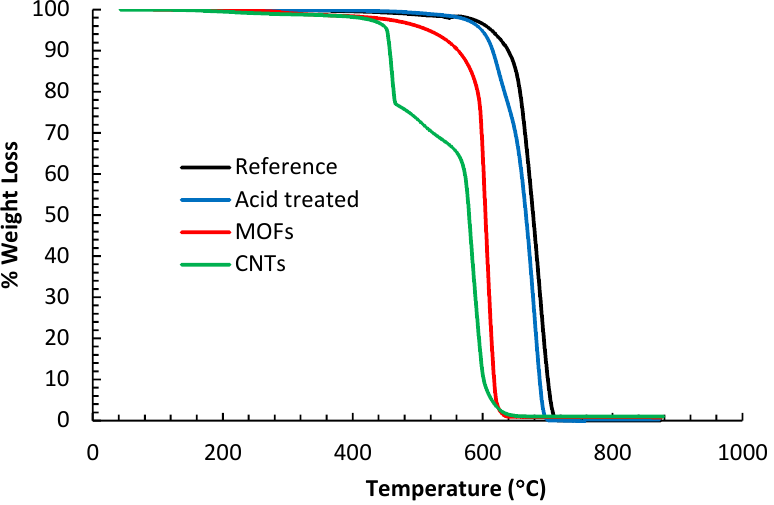
Figure 4. FTIR spectra of carbon fibers after different surface treatments.